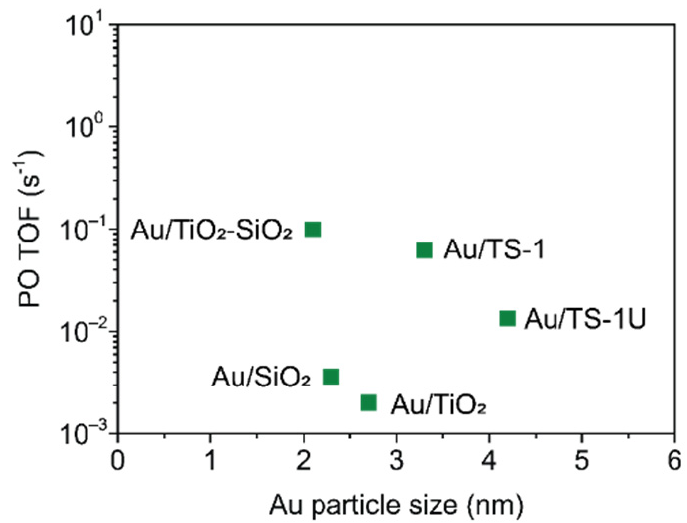
Figure 12. Activity for the formation of propene oxide (PO) in the presence of H 2 and O 2 over Figure 12 . Activity for the formation of propene oxide (PO) in the presence of H gold catalysts supported on Ti 4+ -modified oxides, TiO 2 and SiO 2 . Conditions: 150 mg of catalyst, catalysts supported on Ti 4+ -modified oxides, TiO 10,000 mL/g cat /h flow of 10% of each C 3 H 6 , O 2 and H 2 in He at 200 ◦ /h flow of 10% of each C mL/g cat